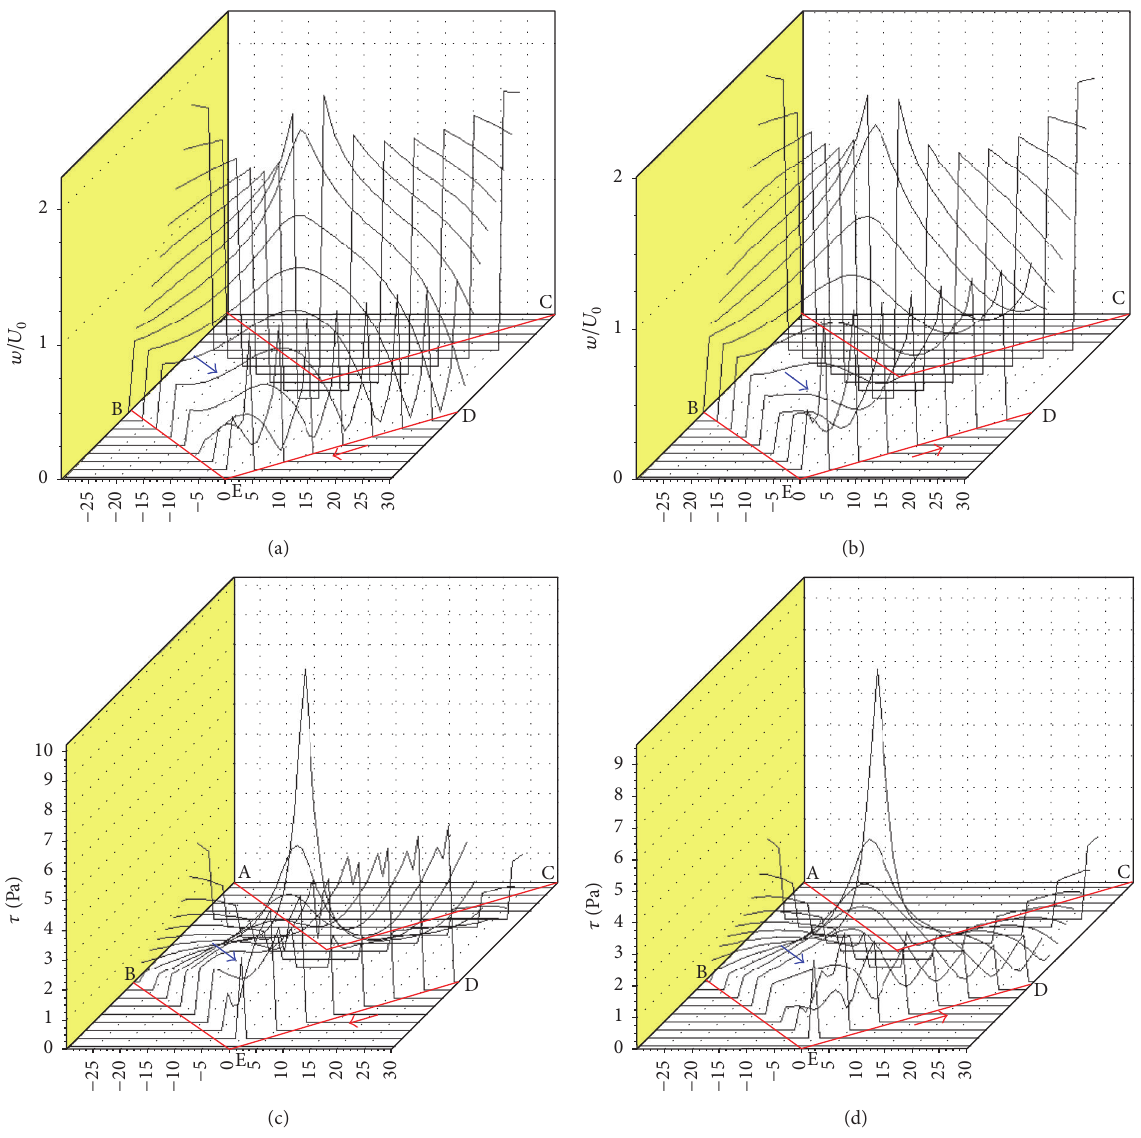
Figure 16: CFD-derived 3D diagrams for dimensionless flow velocity 𝑤 (a, b) and for dimensional tangential stress 𝜏 (c, d) for a Segal die with channel intersection angles ∠ (AOC) = 2 𝜃 = 105 ∘ , where outlet die wall ED moves upstream towards the punching direction with velocity = −𝑈 𝑉 𝑤 0 (a, c), outlet die wall ED moves downstream streamwise with velocity transition times are 1172 ms = 1.172 s (a, c) and 1831ms = 1.831 s (b,